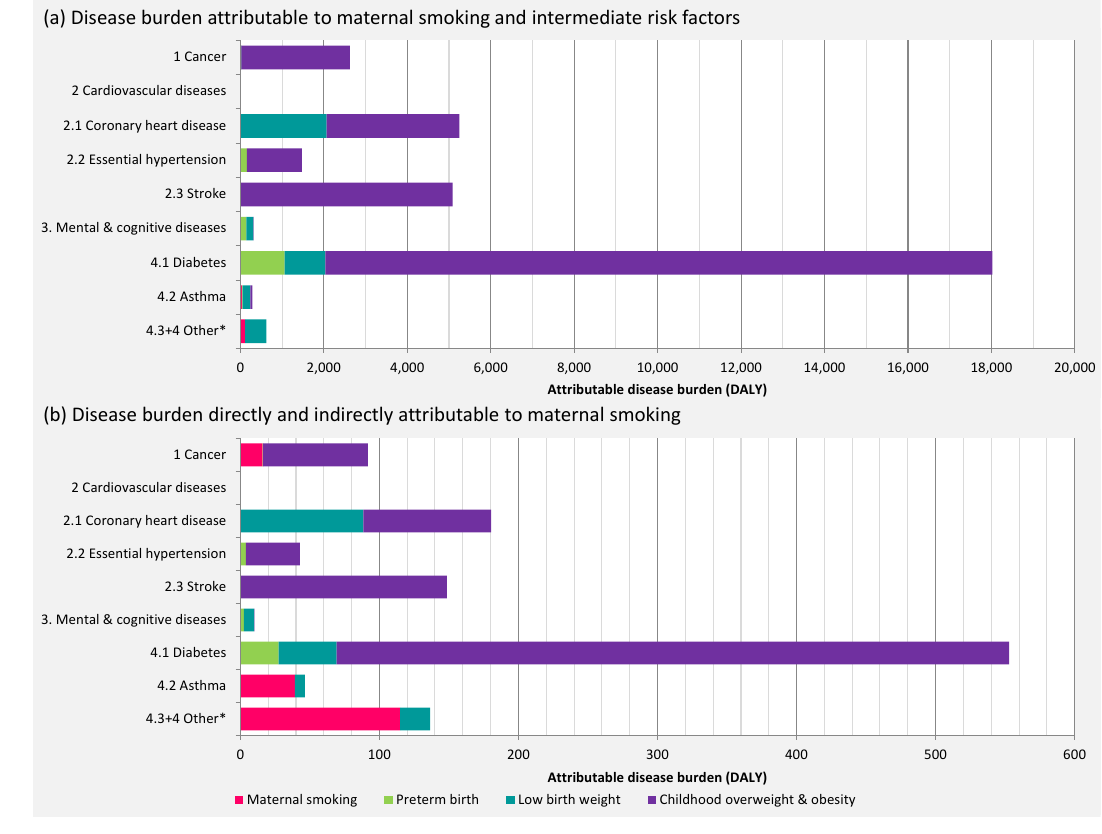
Figure 5. Attributable disease burden (34,000 DALY) by endpoint: ( a ) direct impact; ( b ) direct and indirect impact of maternal smoking (1200 DALY).